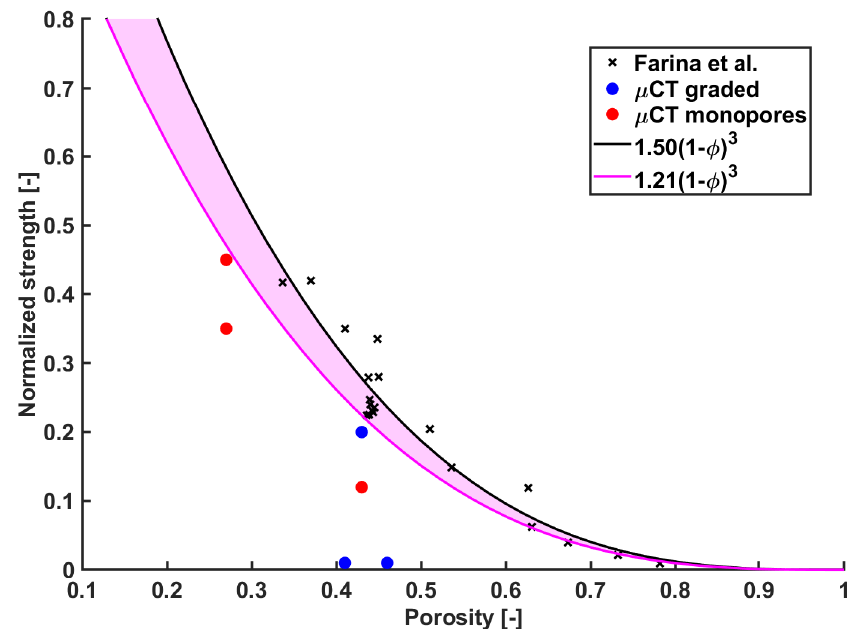
Figure 4. Best fitting curve of ideal scaffolds (black line) from Farina et al. and best fitting curve also considering real scaffolds (purple